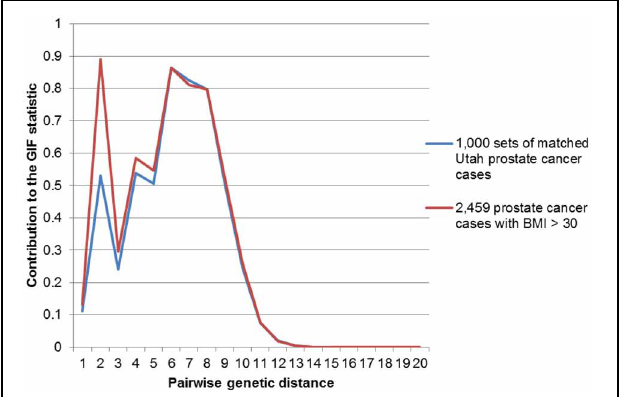
FIGURE 2 | Contribution to the GIF statistic by pairwise genetic distance for cases and controls for prostate cancer cases with a BMI of 30 or greater.